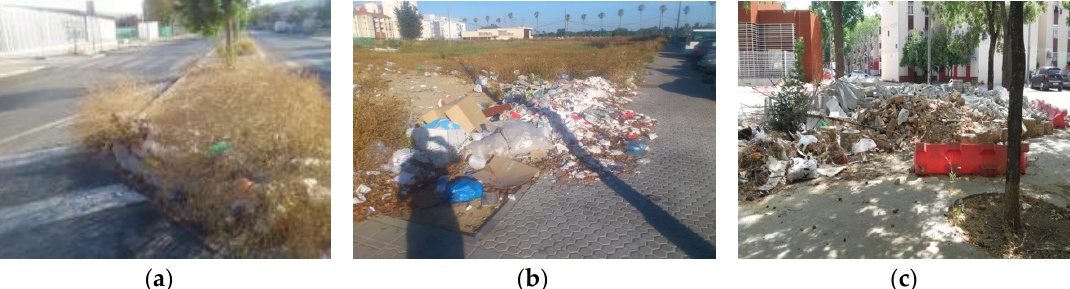
Figure 3. Unhealthy public spaces. ( a ) ¨There are around 40 or 50 homes and only one trash bin trash is left near the trees, the rats, mosquitos, insects, the situation is unbearable, the neighborhood is very dirty”. ( b ) “There used to be two football fields. People used to play football here. I would look out the window and watch. They were going to begin construction here and took away the field and now it has turned into this”. ( c ) “There are limited places for leisure. Perhaps three or four. They accumulate trash and things are left broken”.